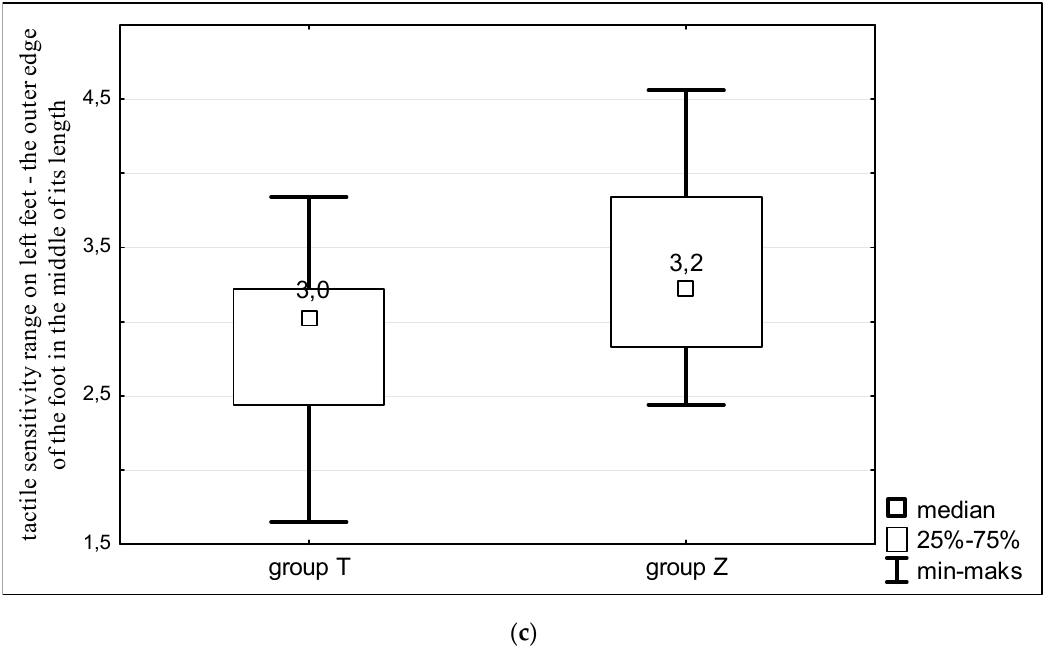
Figure 4. Tactile sensitivity of left feet of women with Turner syndrome (group T) and healthy women (group Z). Sensitivity measurements taken at: ( a ) the first toe; ( b ) external edge of the foot at the small toe; and ( c ) the outer edge of the foot in the middle of its length.